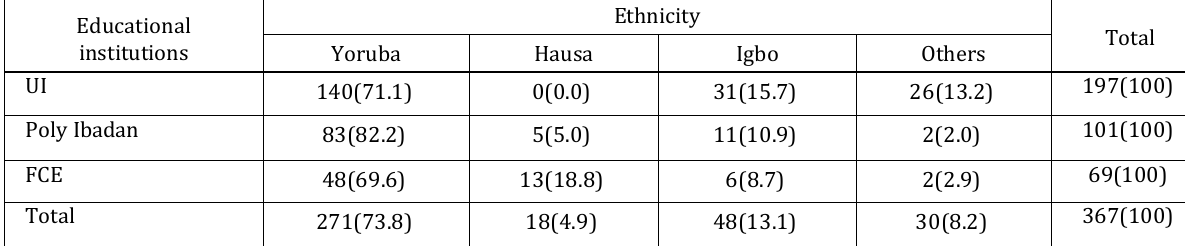
Table 3. Ethnic groups of students (source: Authors’ fieldwork data analysis, 2016)